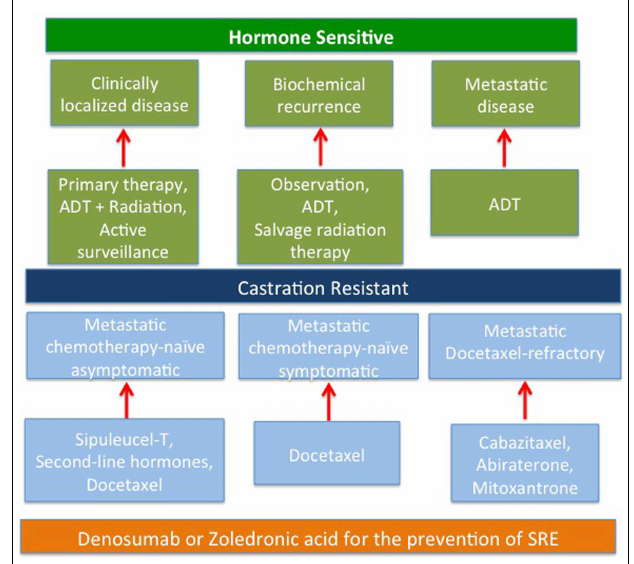
FIGURE 1 |The current treatment paradigm of